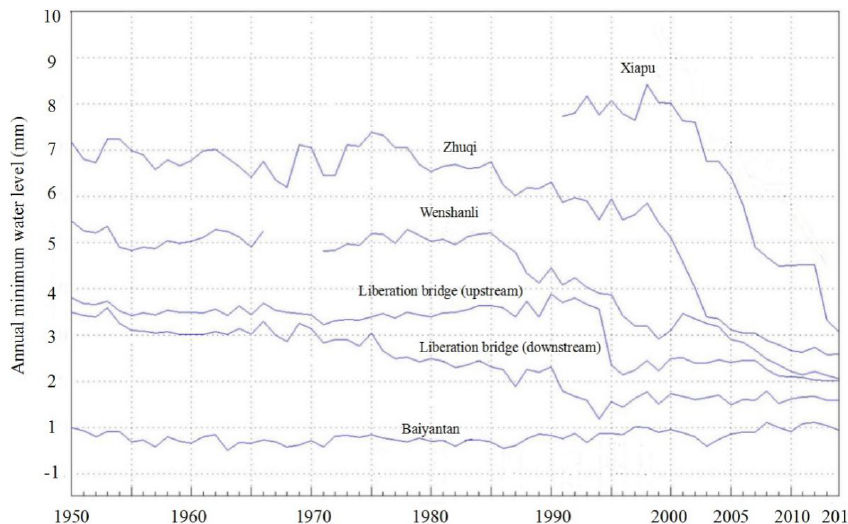
Figure 3. The variation of the lowest water level along the lower reach of the Minjiang River. Table 1. Comparison of water levels at the same discharge at Zhuqi in different years. Discharge at Zhuqi Water level Water level Water level Water level difference Water level